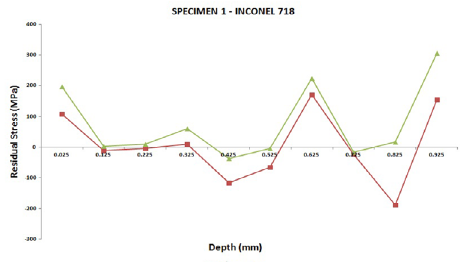
Figure 4. Distribution of the minimum and maximum residual stresses in specimen 1, contemplating the interface region between BM and HAZ of the Inconel 718 alloy